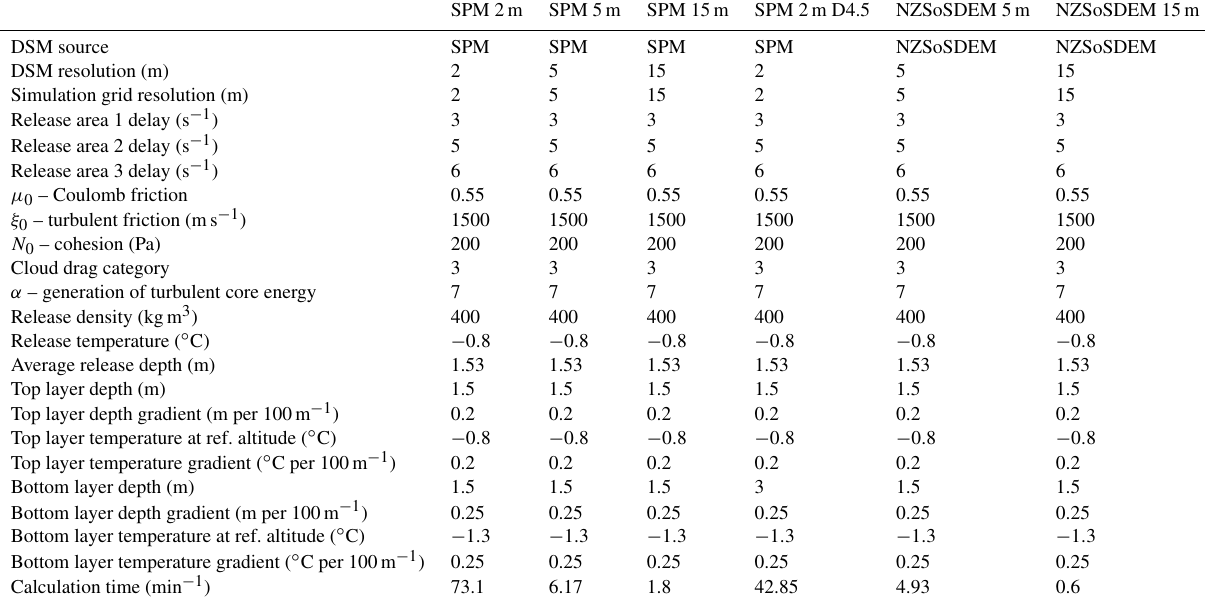
Table A2. RAMMS simulations performed with DSMs derived from satellite photogrammetric mapping (SPM) and the NZSoSDEM for the McPherson avalanche. The friction and entrainment parameters were held constant for each simulation, matching the reference TLS 2m simulation, with the exception of SPM 2m D4.5, which increased the bottom layer snow depth to simulate additional snow available for entrainment in the path. The release area delays are based on time from explosive charge detonation. SPM